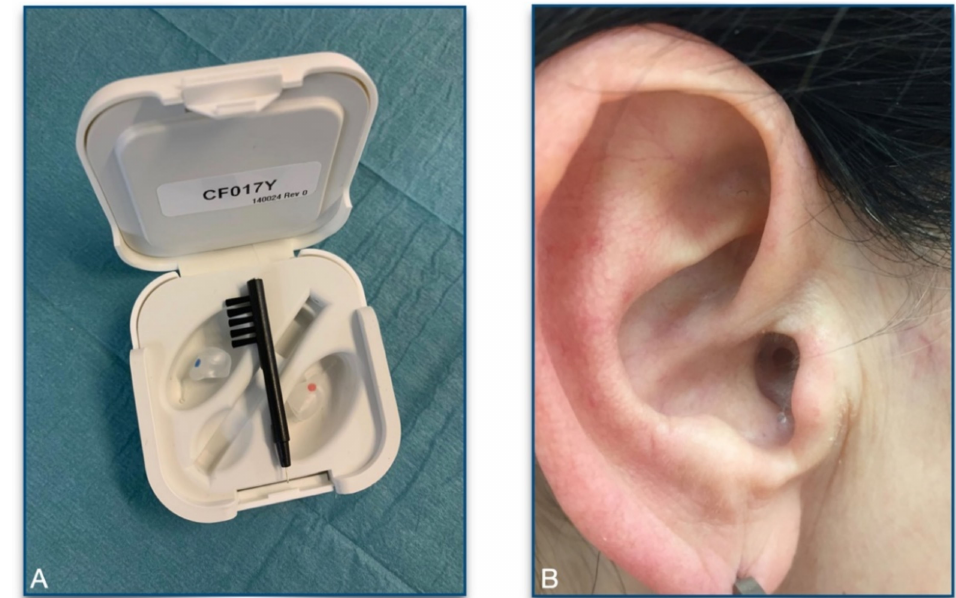
Figure 1. A personalized, compact, and less visible device encourages patients to implement during both circadian cycles of the day. ( A ) Compact Cerezen™ in-ear device kit includes two transparent parts color-coded in correspondence to each ear as well as a cleaning utensil. ( B ) Transparent, personalized ear pods insure low visibility and easy fitting, thus motivating the patient to use